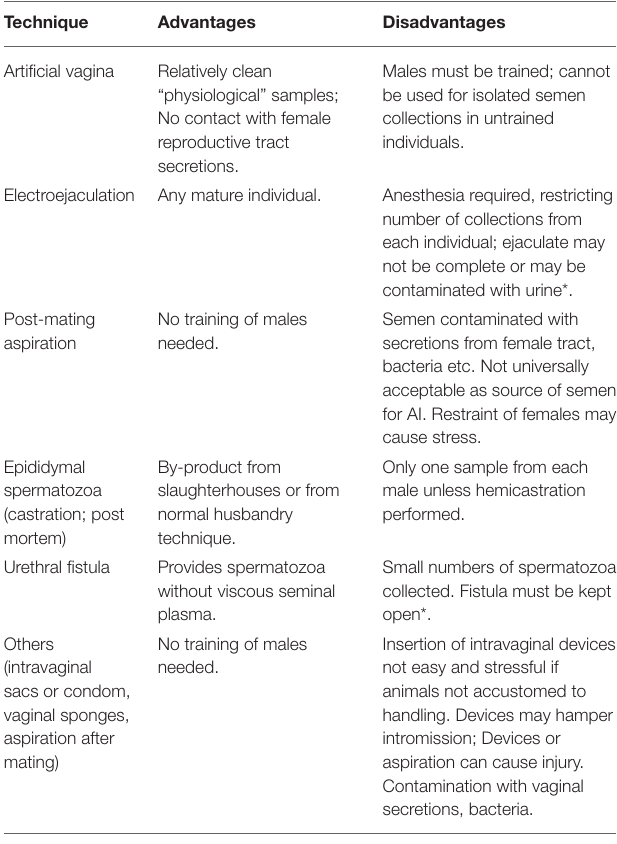
TABLE 1 | Advantages and disadvantages of various semen collection methods in alpacas [modified from